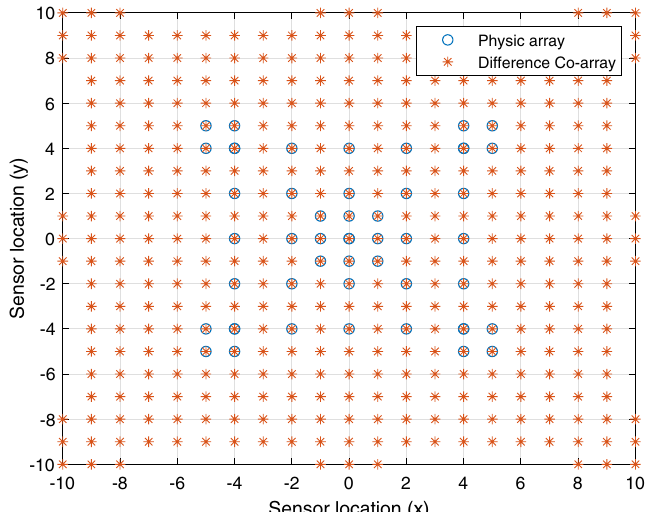
Fig. 8 RMSE versus SNR, snapshots